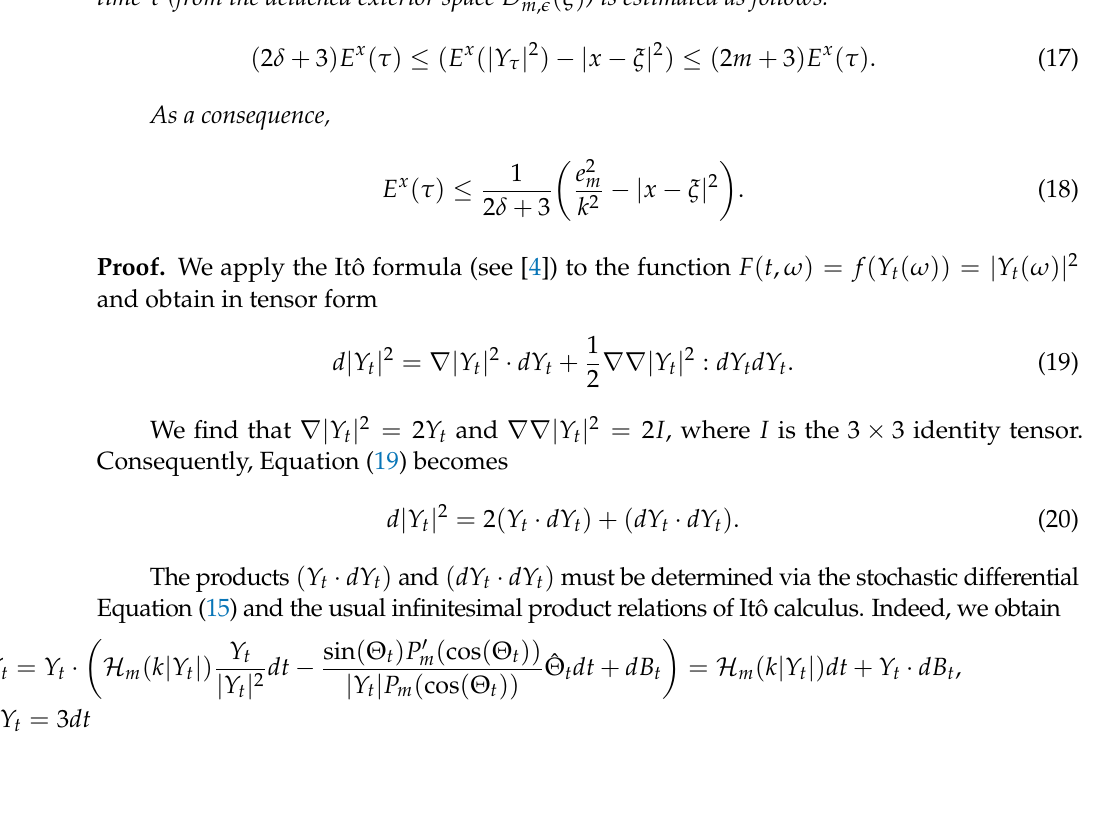
( ξ ) , is usually m , (cid:101)